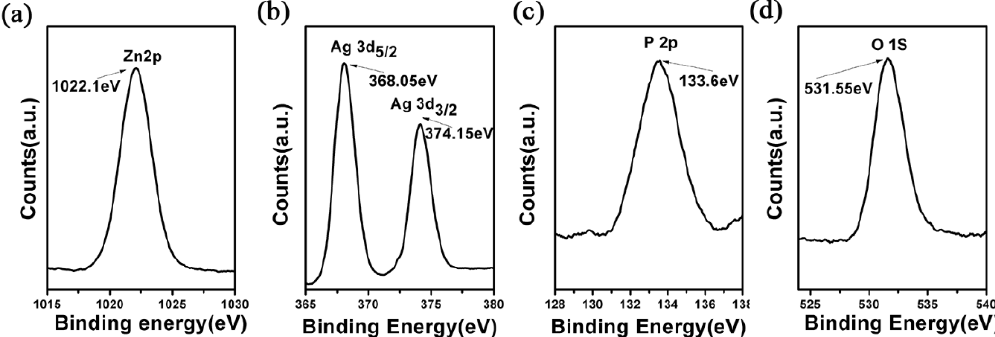
Figure 5. The X-ray photoelectron spectroscopy (XPS) spectra of Zn2p ( a ), Ag3d ( b ), P2P ( c ), and O1S ( d ) in ZnO nanorods + Ag + Ag 3 PO 4 .